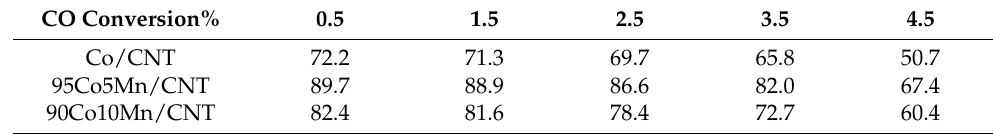
Table 2. Effect of space velocity (L/g.h) on CO conversion%, CH 4 selectivity% and C 5+ selectivity%